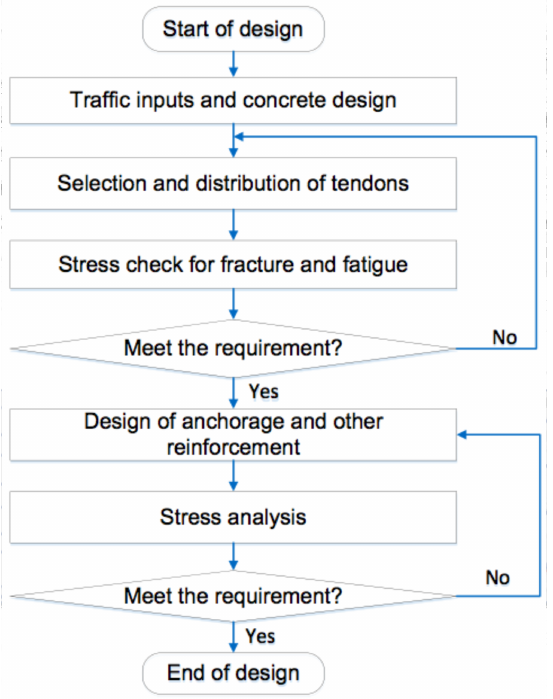
Figure 1. Design procedure of prestressed concrete